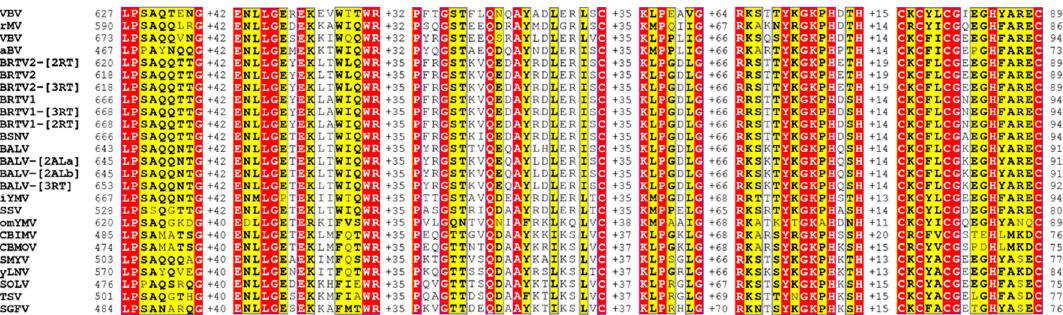
Figure 5. Comparison of highly conserved amino acid residues in the coat protein encoded by the N-terminal half of the ORF 3 product among DBALV-[2ALa], DBALV-[2ALb], DBRTV1, DBRTV1-[2RT], DBRTV1-[2RT], DBRTV2, DBRTV2-[2RT], DBRTV2-[3RT], DBALV-[3RT], DBALV, DBSNV, 14 badnavirus and other members of the family Caulimoviridae (see text for detail). Sequences were aligned with CLUSTAL OMEGA (http://www.ebi.ac.uk/Tools/msa/clustalo/) and coloured using ESPript 3.0 [57], where functional conserved amino acid residues are highlighted with yellow backgrounds and complete consistent residues with red backgrounds. Numbers of the starting and ending amino acids are specified before and after each sequence, respectively. The numbers of residues (gaps) between blocks are presented.